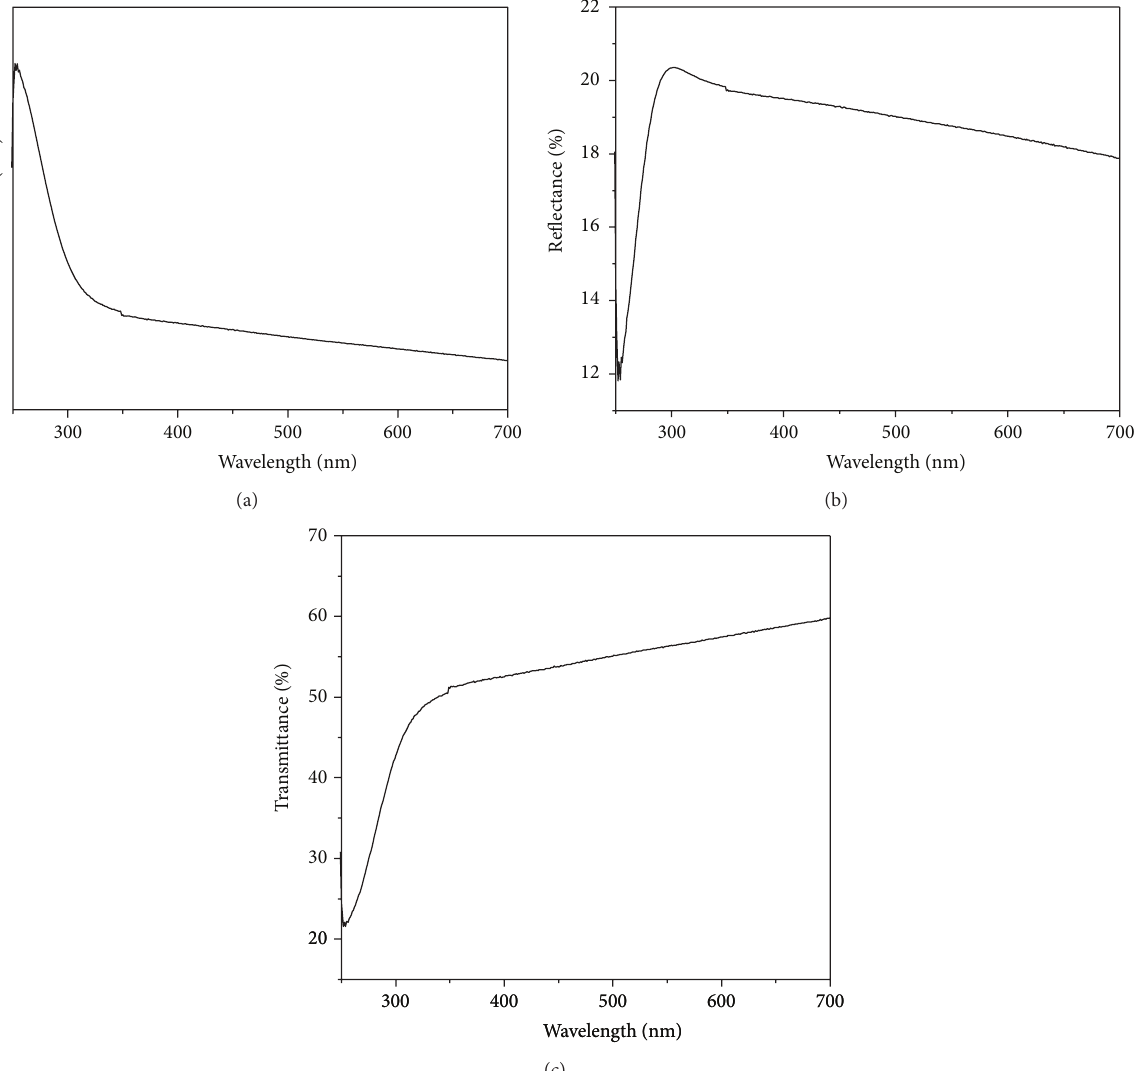
Figure 5: (a) Absorbance, (b) reflectance, and (c) transmittance spectra of nano-BaWO 4 .